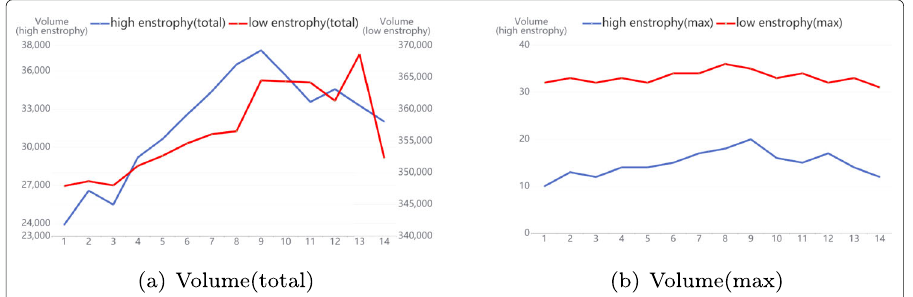
Fig. 3 The line plot for the volume of the components at different enstrophy value during different time of combustion. The left is the total volume of the components, and the right is the max volume of the components. The blue line indicates high enstrophy value, and the red line indicates low enstrophy